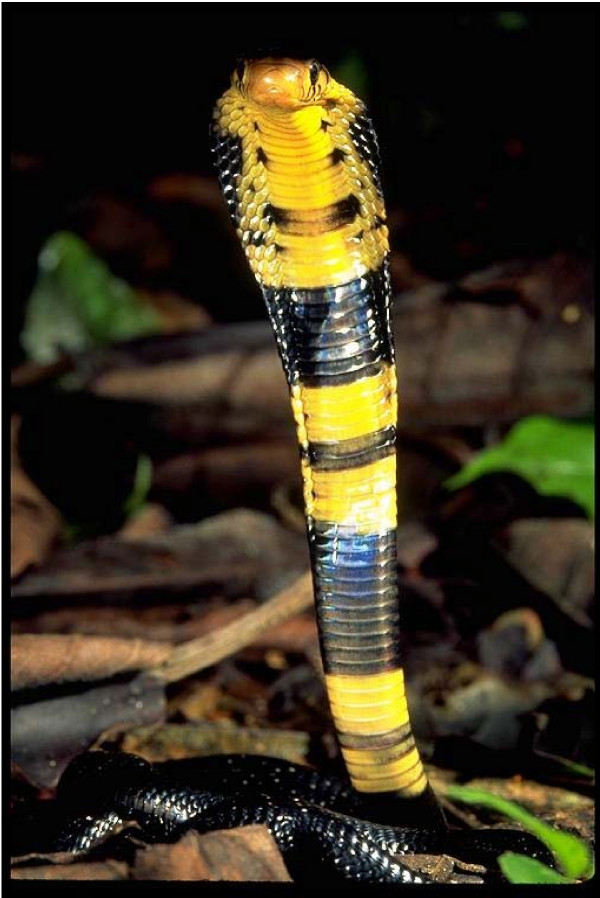
Naja melanoleuca.